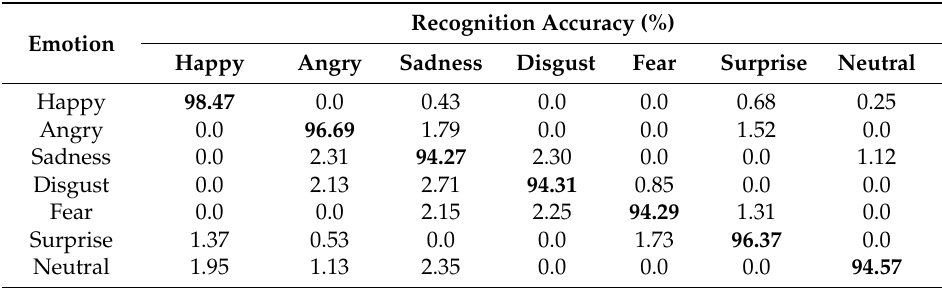
Table 7. Confusion matrix for the Cohn–Kanade database.